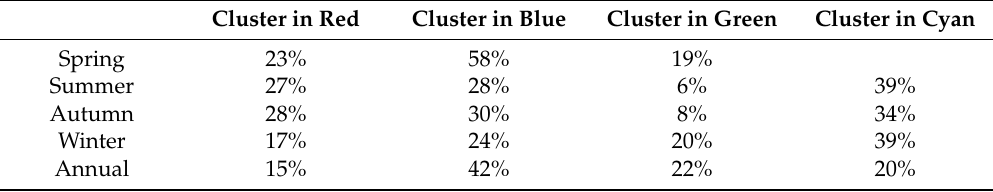
Table 3. Statistics of the cluster results in Figure 12 for each season, from March 2007 to February 2016. Cluster in Red Cluster in Blue Cluster in